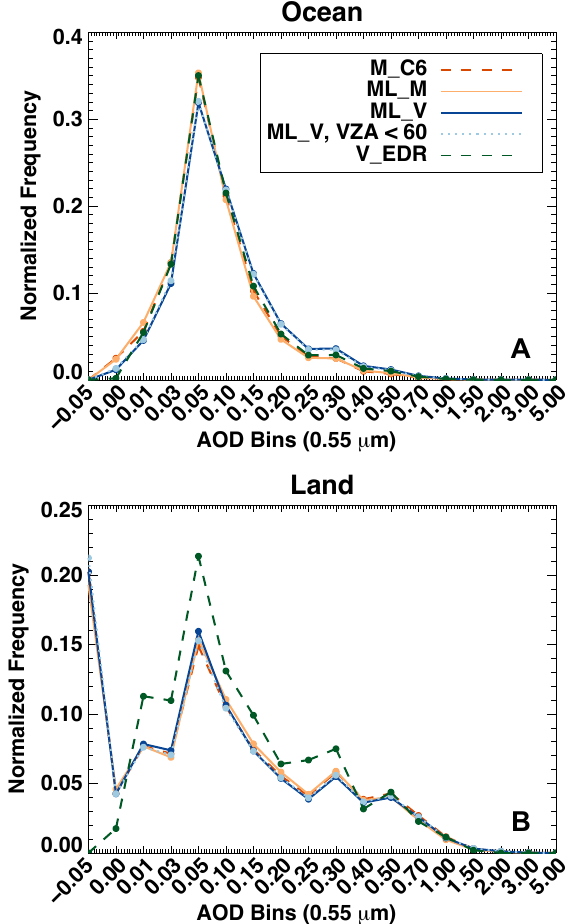
Figure 8. Spring 2013 (March–April–May) relative frequency his- tograms of QA-filtered AOD, retrieved over ocean (top) and land (bottom). Note the non-uniform bin width, and that negative values are allowed in the MODIS C6 and MODIS-like data sets over land. See Table 5 for the number of QA-filtered pixels in each data